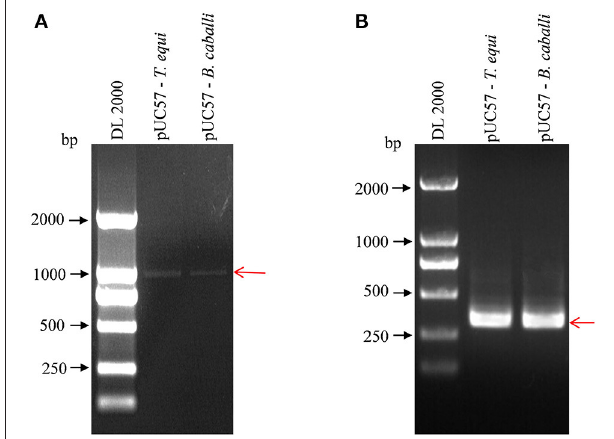
FIGURE 1 | Detection of pUC57- T. equi and pUC57- B. caballi by nested PCR. (A) First round PCR product amplified with 18S Out – F primer and 18S Out – R primer. (B) Second round PCR product amplified with 18S In – F primer and 18S In – R primer. All PCR products were electrophoresed on 1% agarose gels and stained with ethidium bromide.